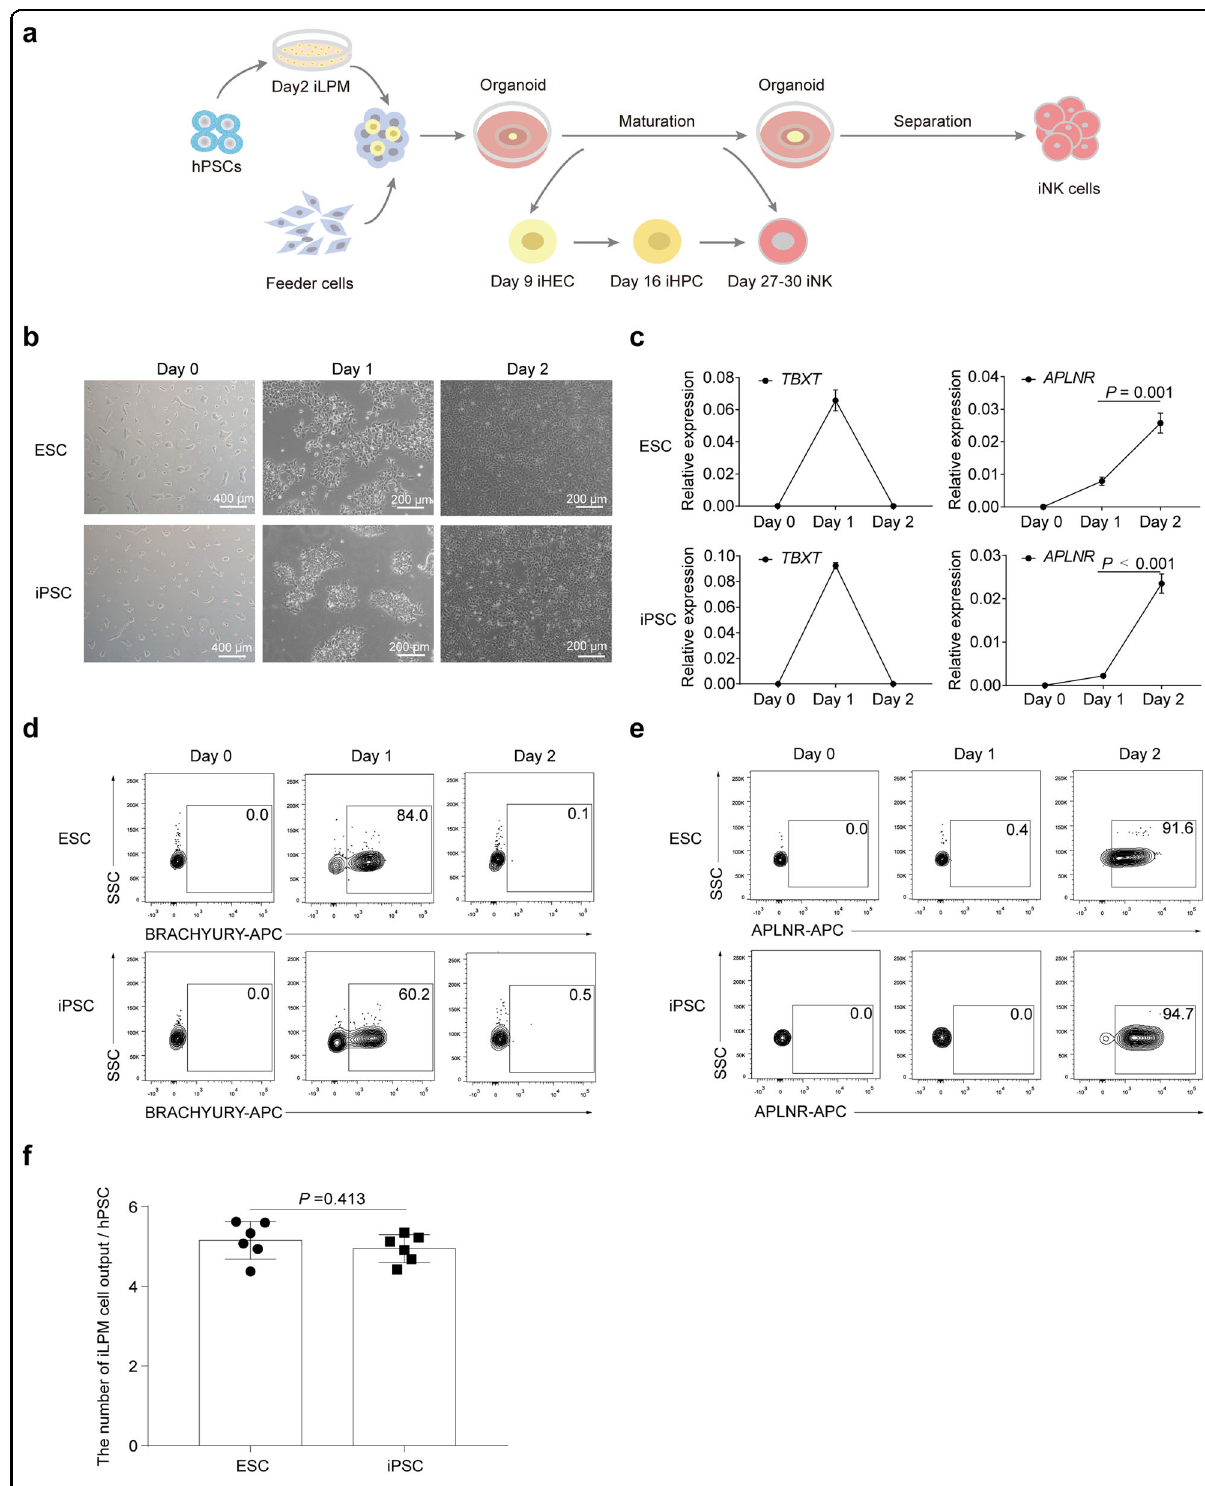
Fig. 1 LPM induction from hPSCs. a Schematic diagram of NK cell regeneration. b Cell images at speci fi ed time points. c Real-time quantitative PCR analysis of TBXT and APLNR gene expression levels at selected time points. β -ACTIN gene was used as internal control. The relative gene expression levels were calculated as 2 – Δ Ct . d Dynamic analysis of BRACHYURY + primitive streak (PS) cells at selected time points. e Dynamic analysis of the APLNR + LPM cells. f Statistics of iLPM cell yields per hPSC input. n = 6 each group. Data were collected from two independent experiments. Two- tailed independent t -test. ESC: human ESC line hPSC-2; iPSC: human iPSC line